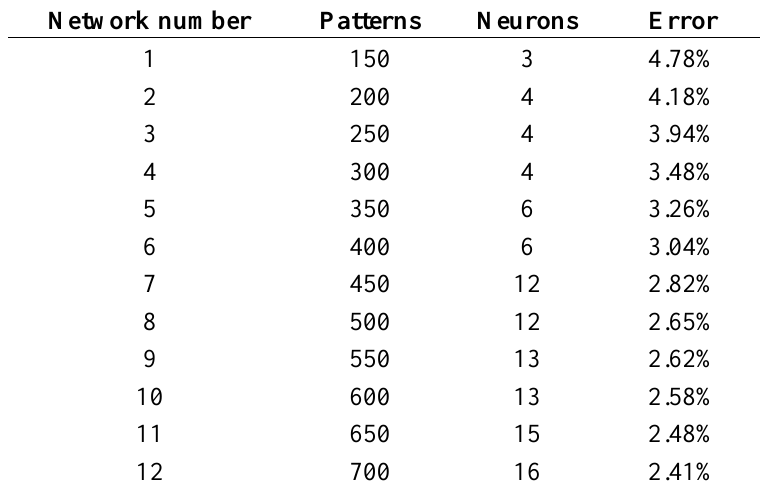
Table 3. Correlation between errors and the number of training patterns.